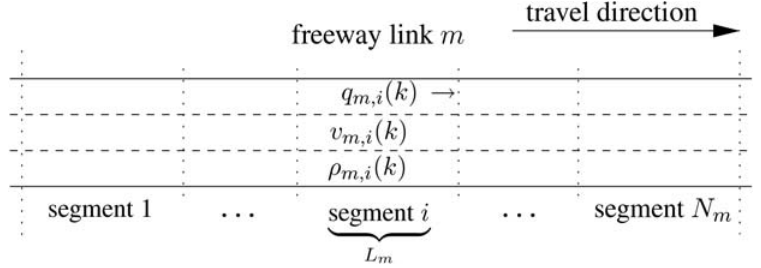
Figure 1. A freeway link in the METANET model divided in segments The traffic state in each segment i of link m at time macroscopic variables average density in veh/km/lane, space mean speed in km/h, and average